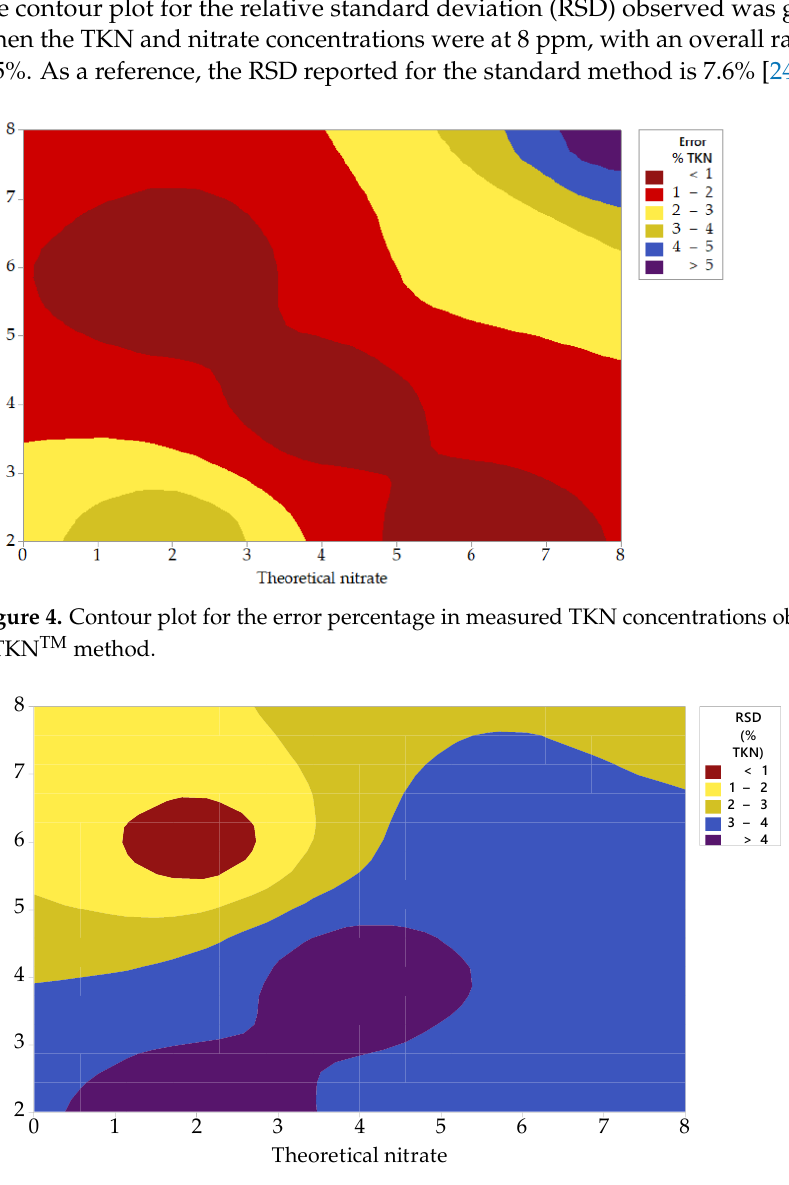
Figure 5. Contour plot for the relative standard deviation in measured TKN concentrations obtained using the s-TKN TM method.